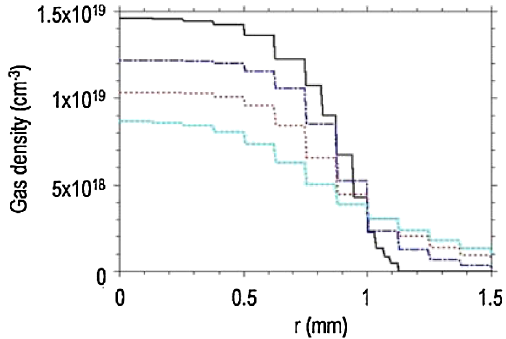
FIG. 7. 8 mm straight nozzle radial density lineouts for 0 (black), 1 (blue), 2 (red), and 3 (teal) mm downstream of the nozzle exit at 20 (cid:1) s